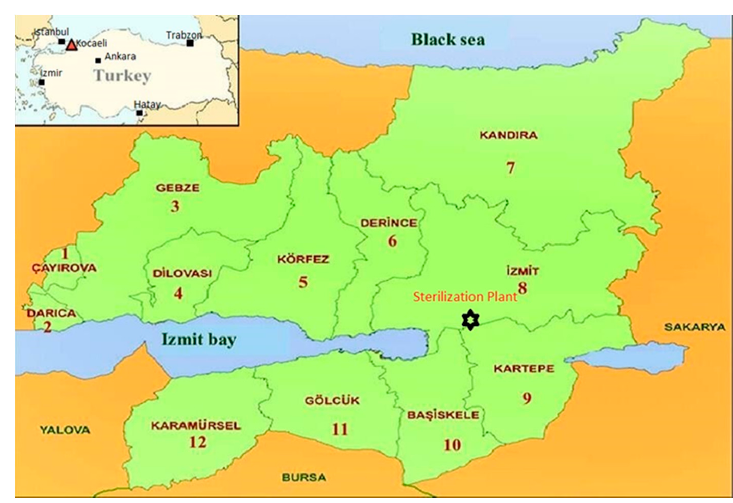
Figure 1. Location map of the study region [19].